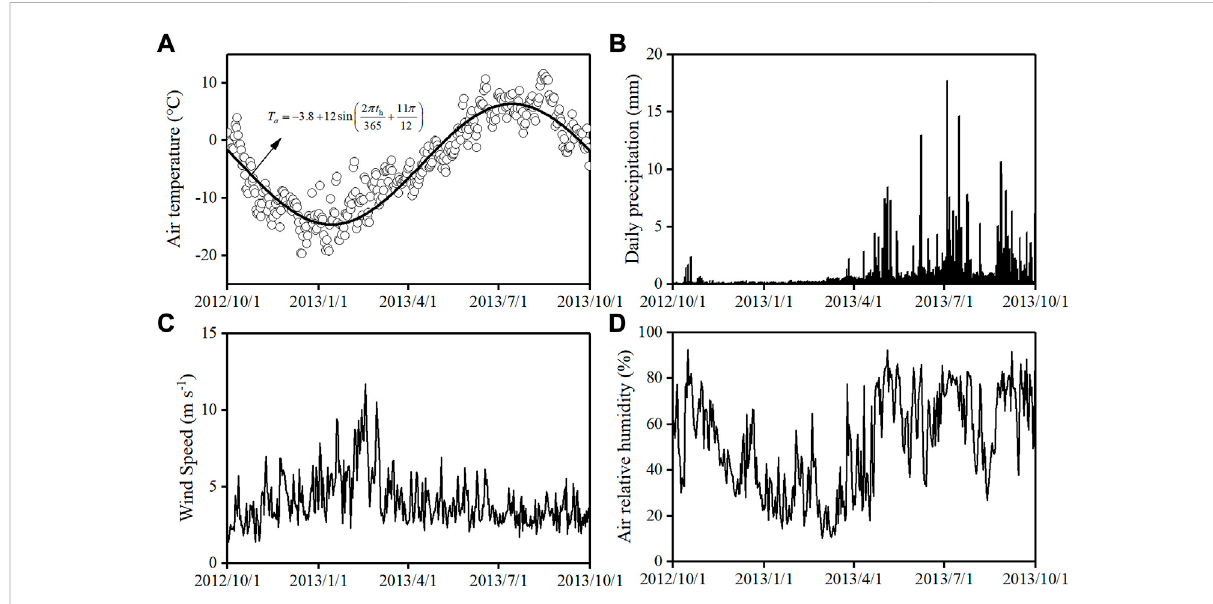
FIGURE 2 The meteorological data at the Beiluhe station (A) air temperature, (B) daily precipitation, (C) wind speed, (D) air relative